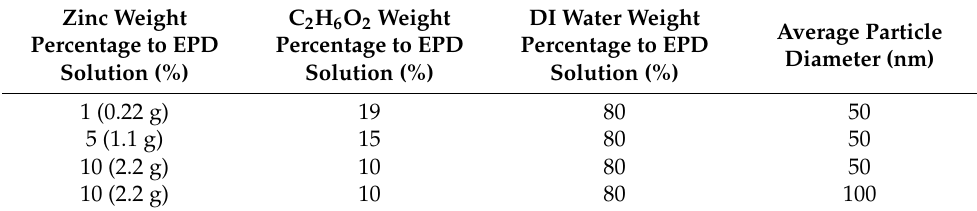
Table 1. Description of EPD solution samples